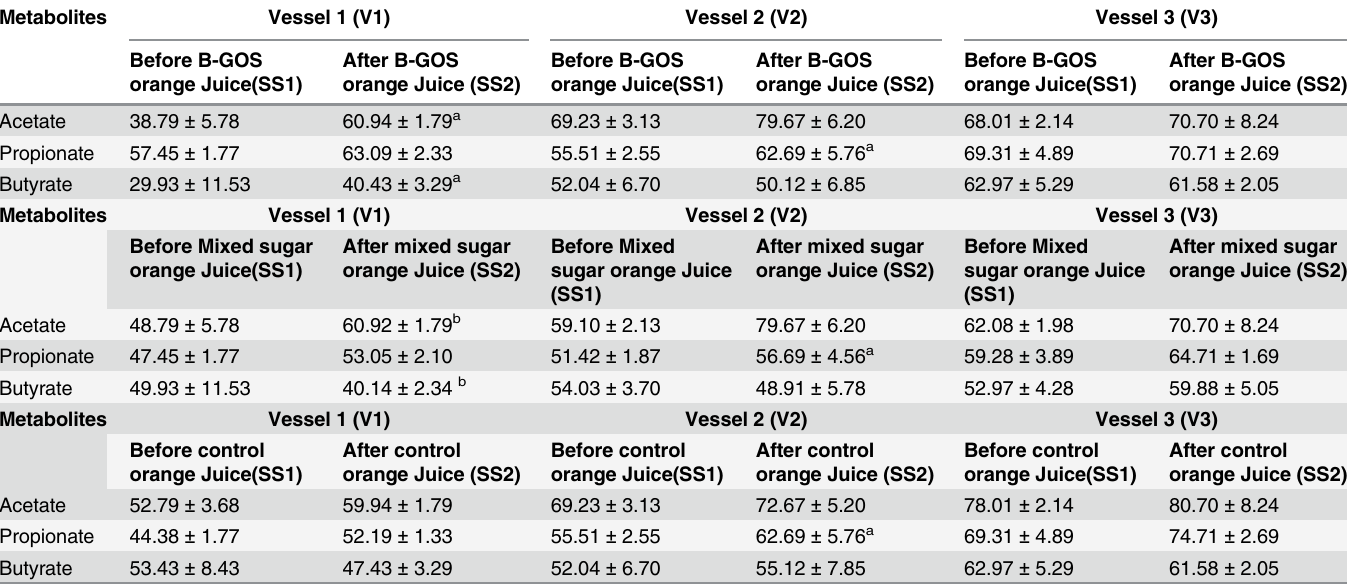
For each sample, measurements were performed in triplicate. Results are means (mM) of the measurements in the two colonic models ± standard deviation (SD). a Designates signi fi cant differences between SS1 and SS2 at con fi dence level of P <